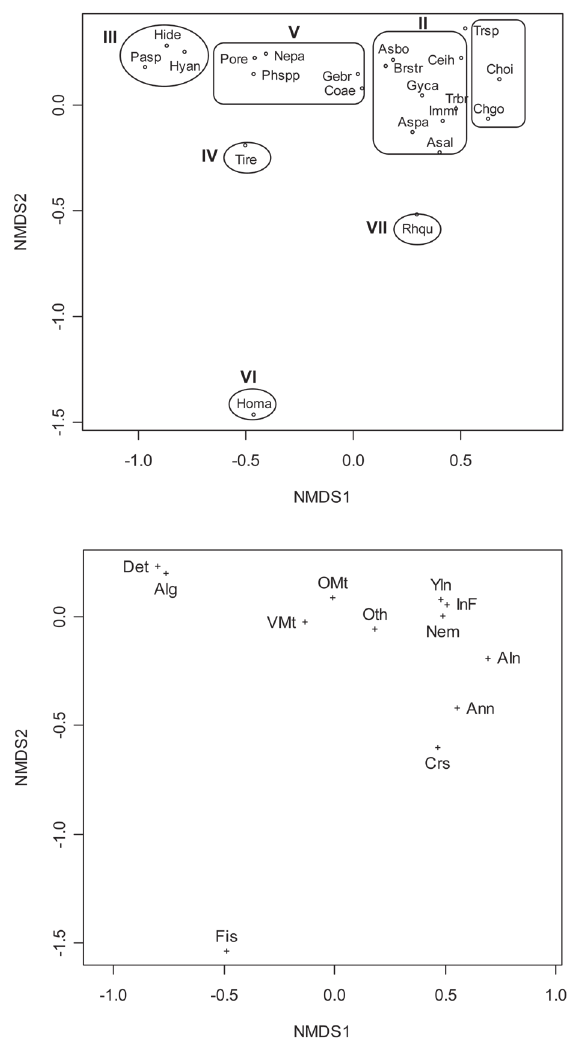
Fig. 2 a-b . Scores of NMDS for the fish species (a) and food items (b) along the axes 1 and 2. Circles and rectangles (a) indicate trophic groups formed by the similarity array. Benthic insectivores (I), insectivores (II), detritivores (III), herbivores (IV), omnivores (V), piscivores (VI), omnivore-carnivores (VII). (b) Alg = algae; Det = detritus; OMt = organic matter; VMt = vegetal matter; Oth = others, YIn = young insects; Fis=fish; AIn = adult insects; InF = insect fragments, Nem= nematodes; Ann = Annelidae, Crs = Crustacea. Codes of species are shown in Table 2.